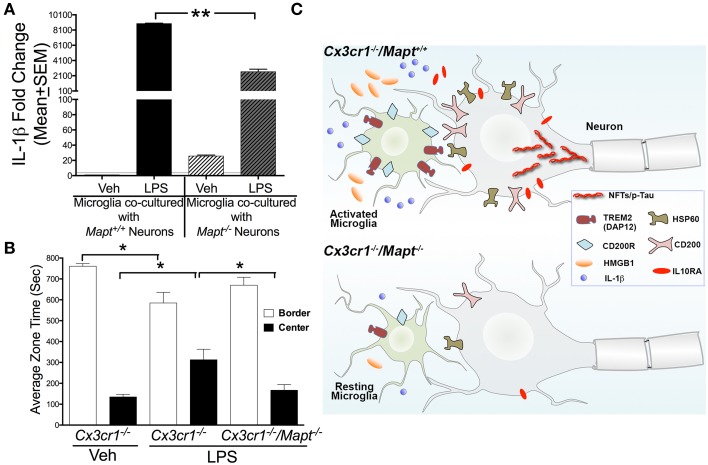
Tau deficiency reduces microglial-IL-1β secretion
in vitro
and lack of inhibition in the
Cx3cr1−/− mice following LPS administration. (A) qRT-PCR analysis reveal LPS induced pro-IL-1β expression in Cx3cr1−/− microglia co-cultured with Mapt+/+ neurons is significantly (**p < 0.01; One-Way ANOVA with Tukey multiple comparison test; n = 3 independent co-cultures; mean ± SEM) higher compared to Cx3cr1−/− microglia co-cultured with Mapt−/− neurons. (B) Two-month-old Cx3cr1−/− and Cx3cr1−/−/Mapt−/− mice administered with LPS (1 mg/kg b.w, daily for 3 days; i.p) or vehicle were subjected to open-field behavioral test (for 15 min) after 7 days post-LPS treatment. LPS treated Cx3cr1−/− mice spent significantly (*p < 0.05; One-Way ANOVA with Tukey multiple comparison test; n = 4 mice per genotype/group; mean ± SEM) less time in the border, but more time in the center of the maze, compared to vehicle injected Cx3cr1−/− mice or LPS injected Cx3cr1−/−/Mapt−/− mice. (C) The working model suggests that in Cx3cr1−/−/Mapt+/+ mice, LPS induces hyperphosphorylation (p-Tau) and possible aggregation of tau as neurofibrillary tangles (NFTs) due in part to the sustained activation of Cx3cr1−/− microglia. This results in upregulation of various inflammatory regulators including neuronally derived ligands (HSP60, CD200, HMGB1), microglial receptors (TREM2/DAP12 and CD200R), IL-1β and IL10RA that are needed to restrain reactive microglia. Despite activation of various negative regulatory pathways of microglia, microglia continue to show significant activation due to the deficiency of the CX3CL1-CX3CR1 communication and LPS. Sustained activation of Cx3cr1−/− microglia leads to neurotoxicity possibly mediated by further tau hyperphosphorylation and by the elevated IL-1β signaling. Deficiency of tau in Cx3cr1−/−/Mapt−/− mice show reduced microglial activation, significant reduction in inflammatory mediators including IL-1β and HMGB1, overall decrease in neuron-microglia restraint signaling molecules and thus prevents inflammation-induced, tau-mediated, neurotoxicity.